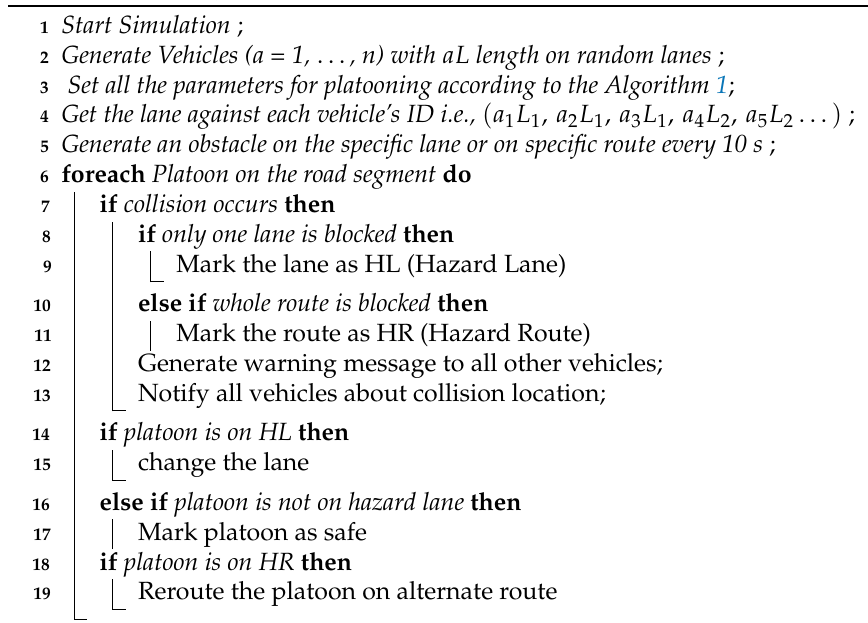
Algorithm 2: Algorithm for collision